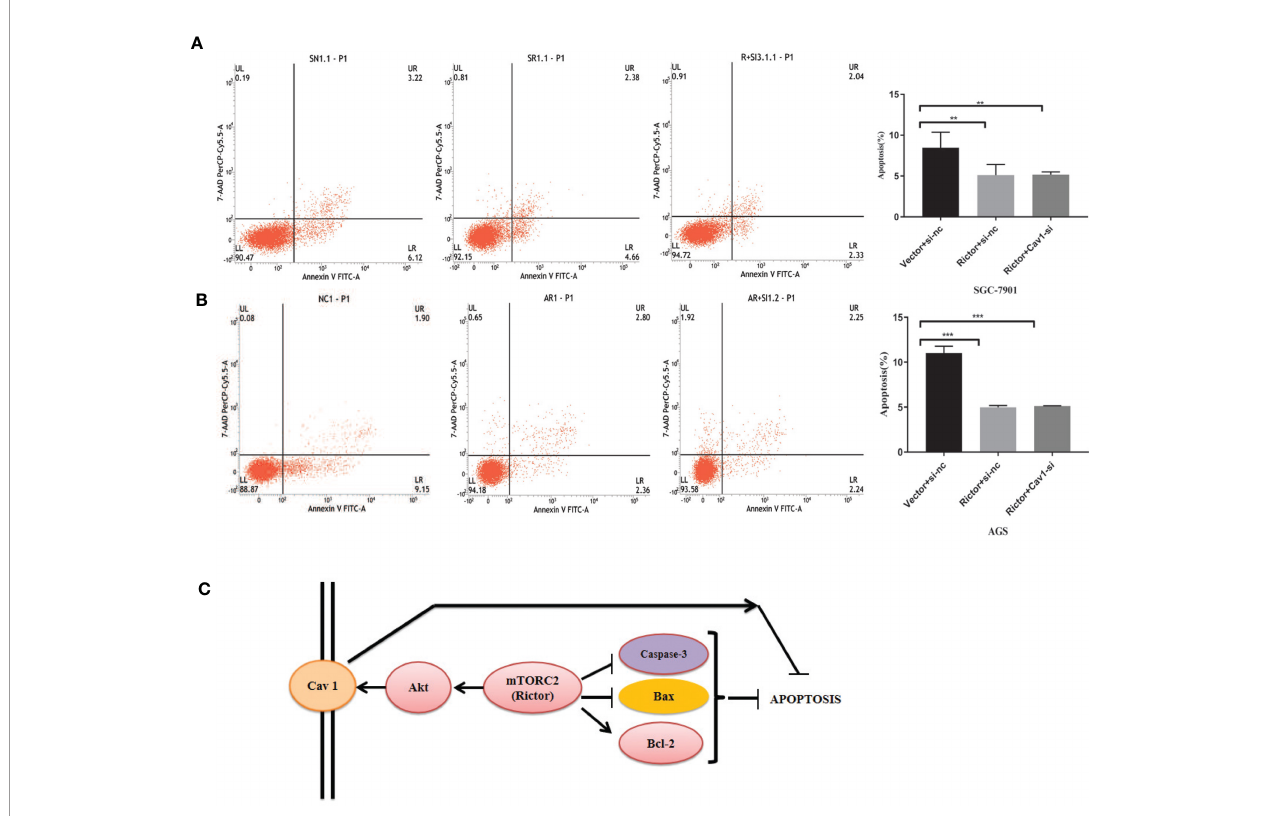
FIGURE 6 | Cav 1 knockdown has no effect on apoptosis inhibition induced by Rictor overexpression. (A) Co-transfection of Rictor plasmid and Cav 1-siRNA in SGC-7901 cells indicated that knocking down Cav 1 did not affect the inhibition of Rictor on apoptosis (n=3). (B) Co-transfection with Rictor plasmid and Cav 1-siRNA in AGS cells indicated that knocking down Cav 1 did not affect the inhibition of Rictor on apoptosis (n=3). Values represent the Means ± SD. *P < 0.05, **P < 0.01 and ***P < 0.001 were calculated using Student ’ s t-test. (C) Signaling pathway of Rictor and Cav